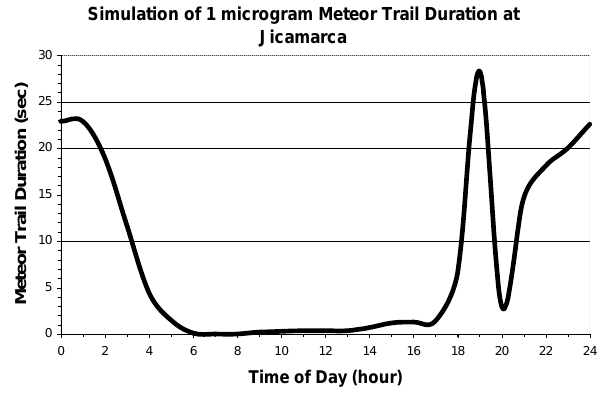
Fig. 7. Simplified model of the nominal diurnal variation of mi- crometeoroid velocity used in the 24h simulation presented in Fig. 8. Simulated non-specular trail durations produced by 1 micro- Figure 8. Simulated non-specular trail durations produced by 1 microgram meteoroids as a function of Fig. 8. Note that a night time meteor velocity of about 30km/s gram meteoroids as a function of time of day. This simulation uses; time of day. This simulation uses; the diurnal electron density of the ionosphere, zonal drift speed, and is a near ideal speed for generating long duration meteor trails, a the diurnal electron density of the ionosphere, zonal drift speed, and the meteor velocity cycle to predict non-specular trail duration at Jicamarca. The electron density of the contributing factor to the increase in long duration trails at night. the meteor velocity cycle to predict non-specular trail duration at Ji- ionosphere has a very apparent effect on duration, during the daytime the predicted trail duration is 1-2 camarca. The electron density of the ionosphere has a very apparent seconds. The electron density has the strongest affect on non-specular trail duration. During the evening effect on duration, during the daytime the predicted trail duration is and into night time when the electron density becomes less dense, zonal drift speed plays a major role in 1–2s. The electron density has the strongest affect on non-specular determining trail duration. Zonal drift speed’s effect on trail duration is most easily seen between 18:00 trail duration. During the evening and into night time when the elec- and 20:00 hours. During this period there is a large jump in trail duration from a 3 second duration up to tron density becomes less dense, zonal drift speed plays a major role a 27 second and back down again during the prereversal enhancement. in determining trail duration. Zonal drift speed’s effect on trail du- ration is most easily seen between 18:00 and 20:00h. During this period there is a large jump in trail duration from a 3s duration up to a 27s and back down again during the prereversal